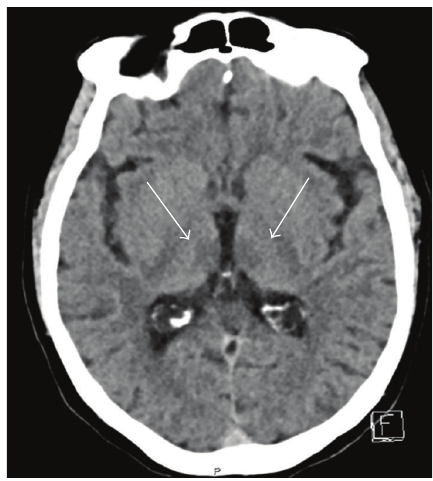
Figure 2: CT on admission. The white arrows show the hypodensi- ties seen medial in the thalamus